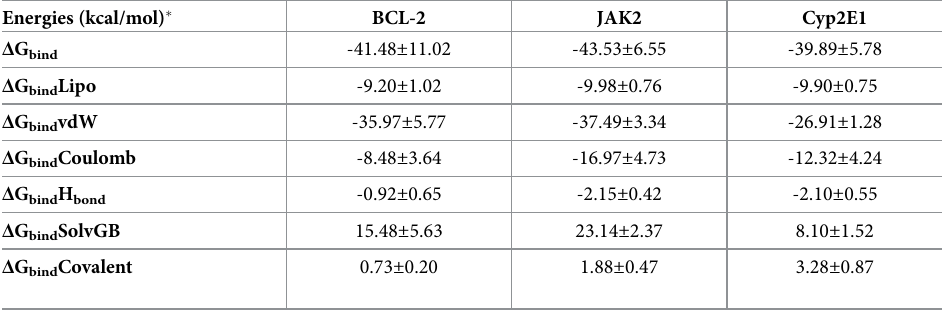
Table 4. Binding energy calculation of quercetin with BCL-2, JAK2 and Cyp2E1 and non-bonded interaction energies from MMGBSA trajectories. Energies (kcal/mol)